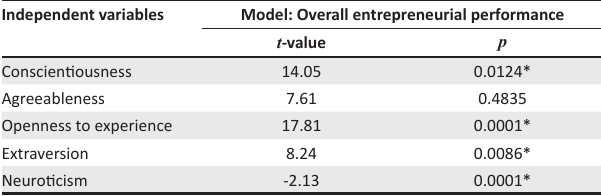
TABLE 4: Correlation results of personality dimensions and overall entrepreneurial performance. Personality